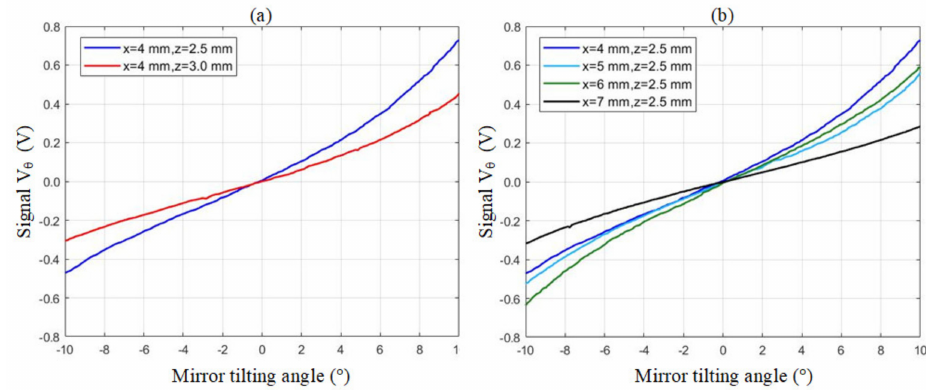
Figure 4. ( a ) The same magnet-sensor gap with different sensor-sensor distance. ( b ) The same sensor-sensor gap with different magnet-sensor gap.